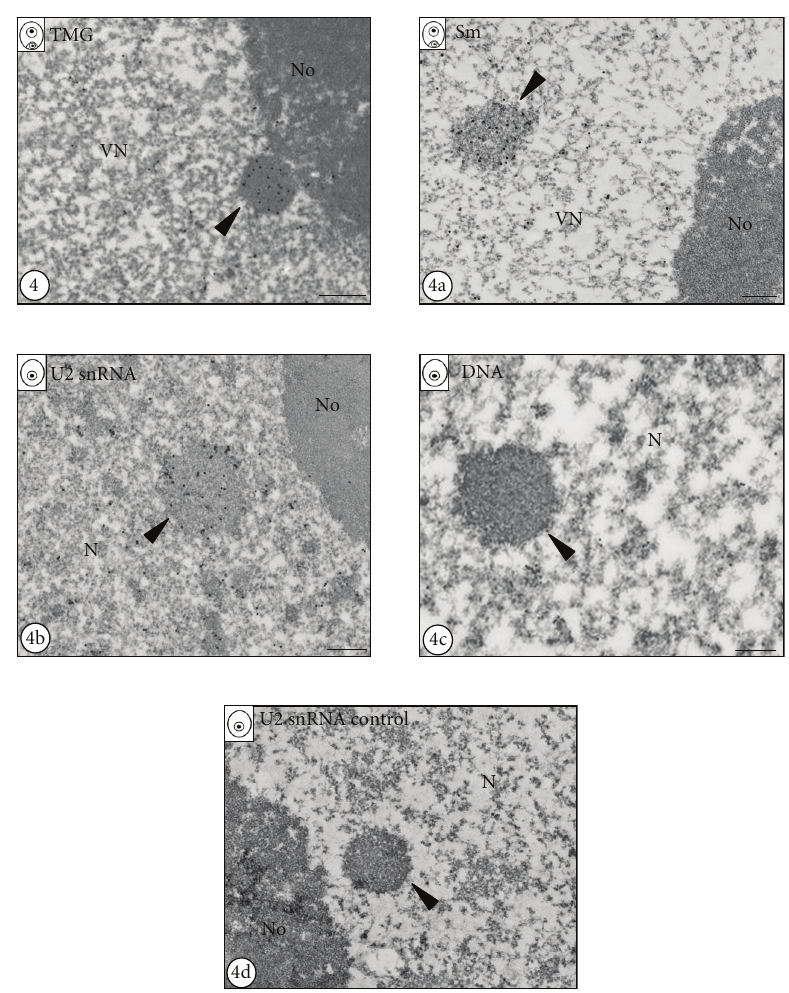
Figure 4: Immunogold localization of snRNP-indicating molecules in nuclear bodies of microspore and vegetative cell of young pollen grain (N-nucleus, No-nucleolus, VN-vegetative nucleus). Bars-0.5 μ m. Figure 4. Immunogold labelling of TMG snRNA in the vegetative nucleus of young pollen grain is shown. Strong labelling can be observed in the nuclear body (arrowhead) localized in close proximity to the nucleolus. Figure 4a. Ultrastructural Sm protein localization in the vegetative nucleus of young pollen grain is shown. Numerous gold particles are concentrated over the nuclear body (arrowhead). Figure 4b. In situ hybridization to U2 snRNA is shown. The presence of U2 snRNA over the nuclear body can be seen in the microspore nucleus (arrowhead). Figure 4c. DNA labelling using TdT technique in polarized microspore nucleus (N-nucleus) is shown. No labelling can be seen in the nuclear body (arrowhead). Figure 4d. Control reaction of in situ hybridization performed using U2 snRNA sense probe (N-nucleus, No-nucleolus) is shown. No gold particles can be seen over the nucleoplasm and nuclear body (arrowhead) localized in close proximity to the